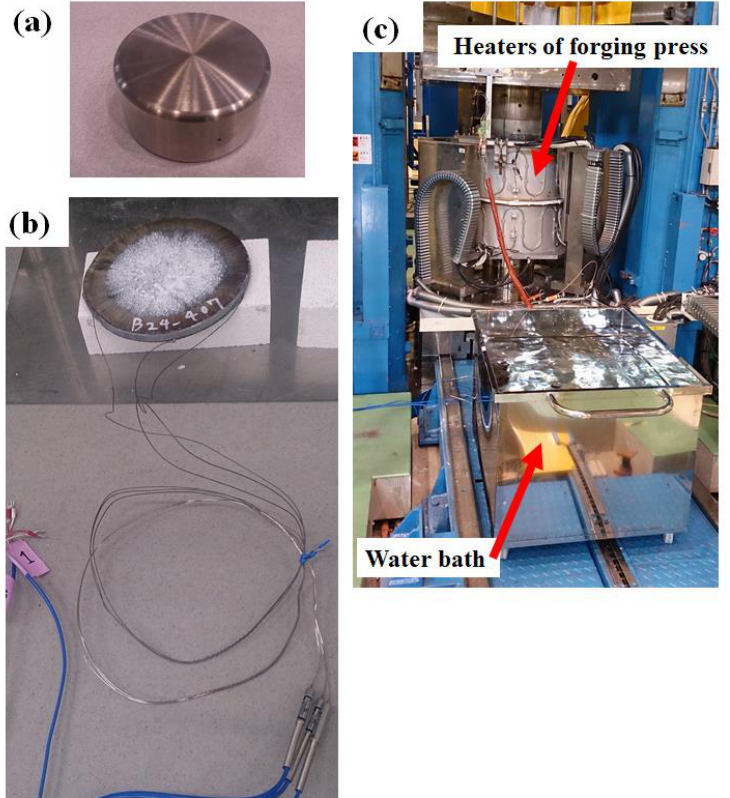
Figure 1. Workpiece ( a ) before and ( b ) after forging. ( c ) External view of the heaters of the 1500-ton forging press and a water bath located next to the press.